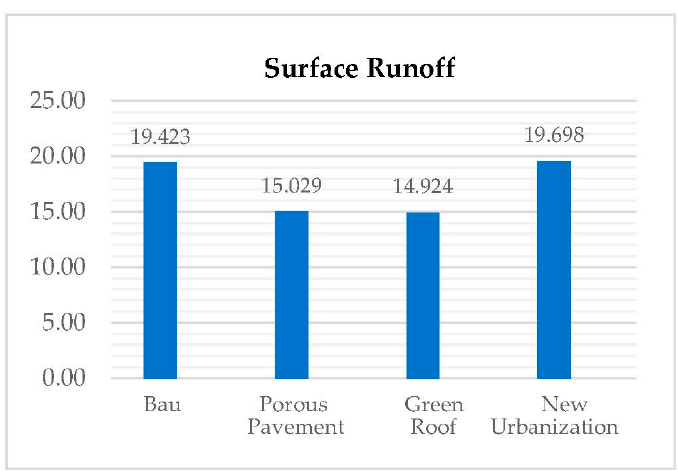
Figure 12. Comparison between surface runoff results.